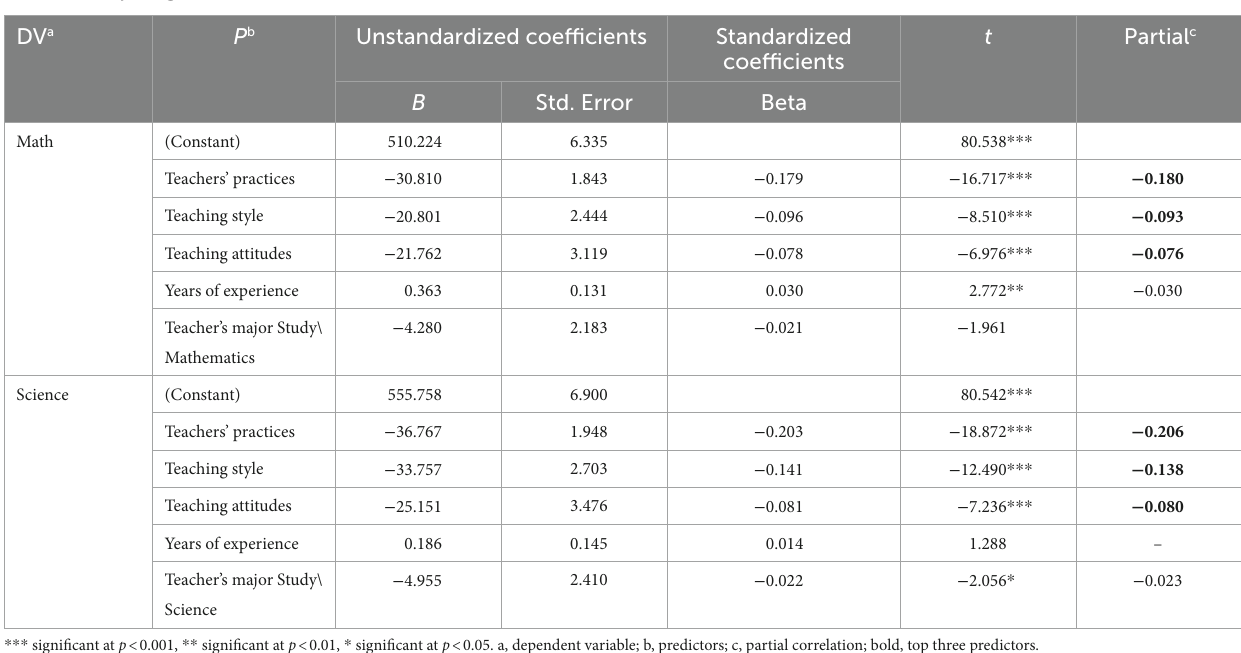
TABLE 1 Multiple regression coefficients.